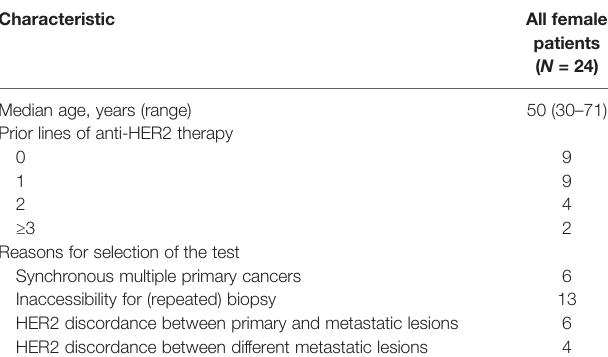
TABLE 1 | Patient